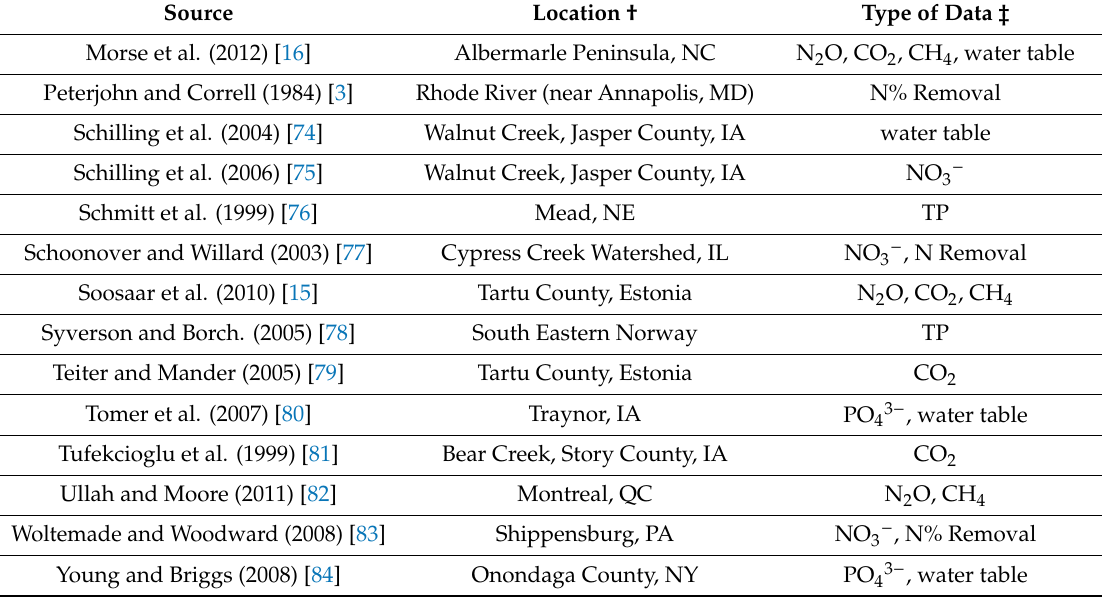
Table 4. Summary of data used to validate the individual models in RZ-TRADEOFF.